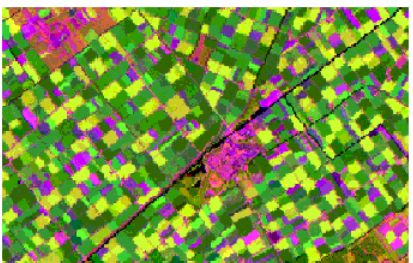
Figure 1. Landsat Thematic Mapper (TM) image (bands 3, 4, 5), Biddinghuizen, the Netherlands The image was georeferenced to the Dutch national triangulation system using a first-degree affine transformation.